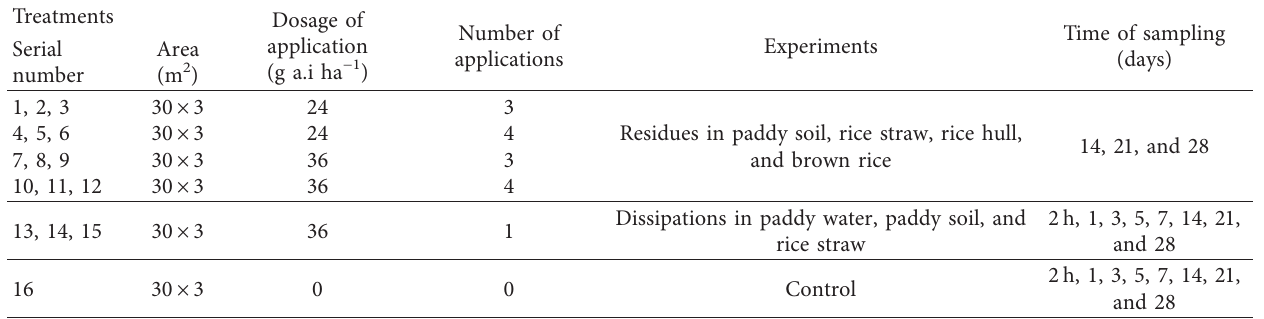
Table 1: Design of field experiments for the residue and dissipation